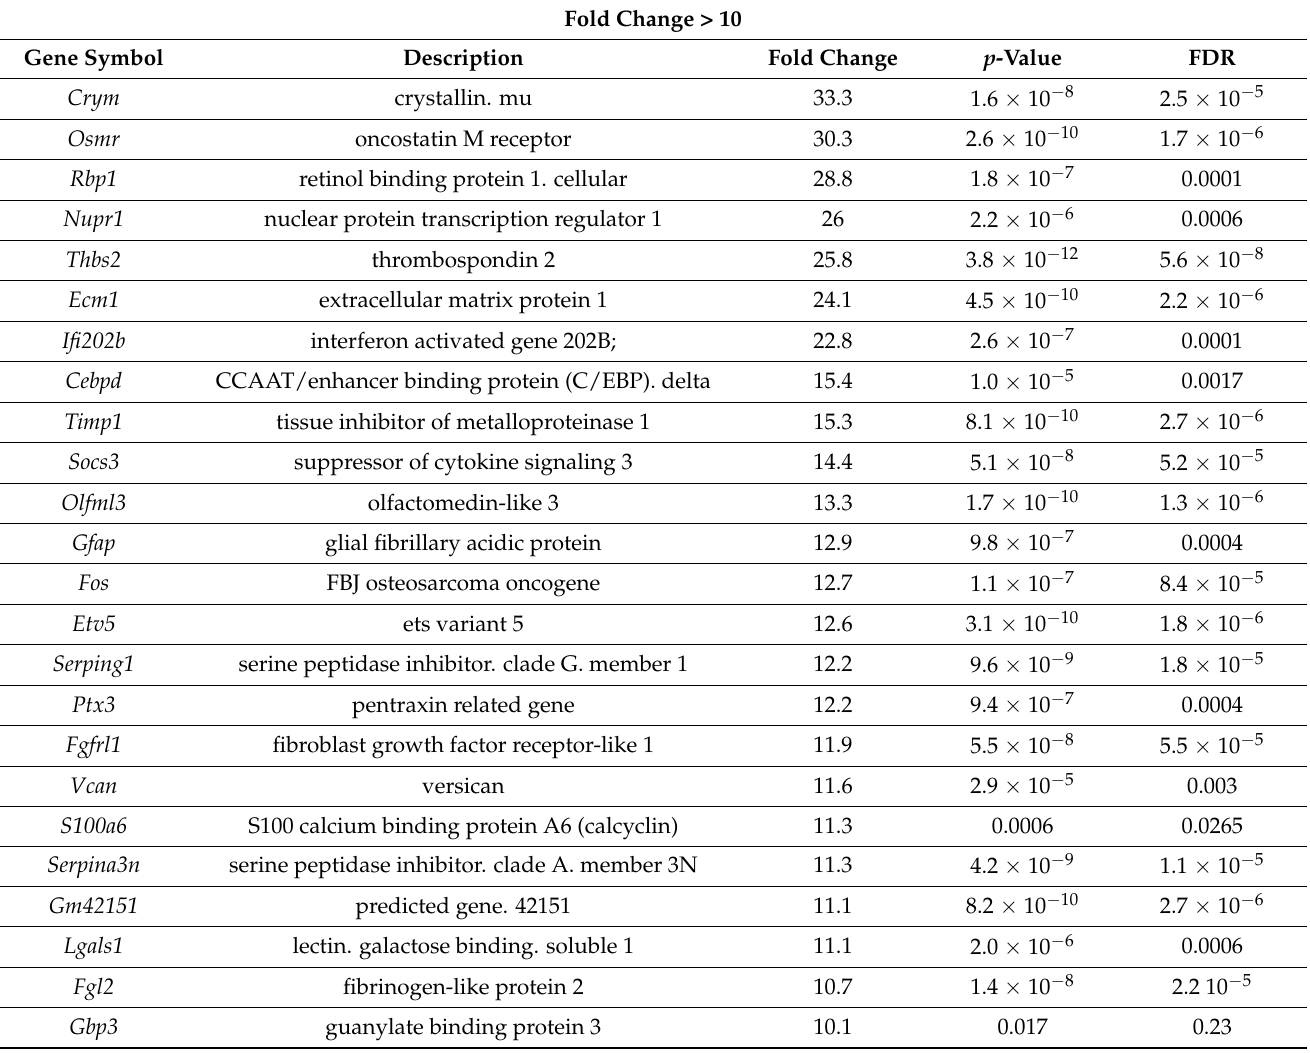
Table 1. Main post injury up- and downregulated genes. Fold Change > 10